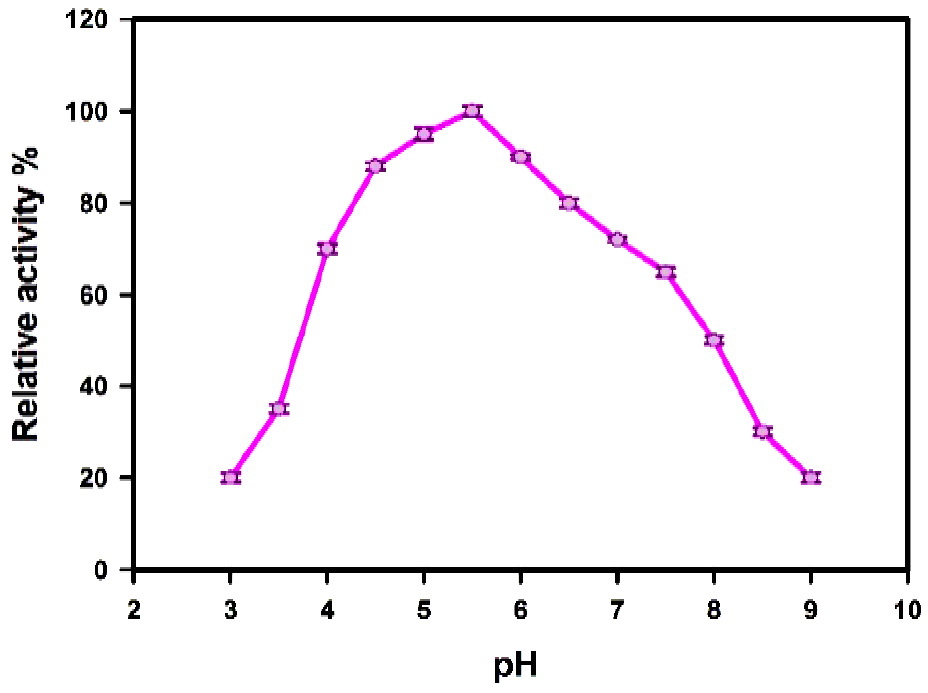
Figure 9. pH stability of purified xylanase.